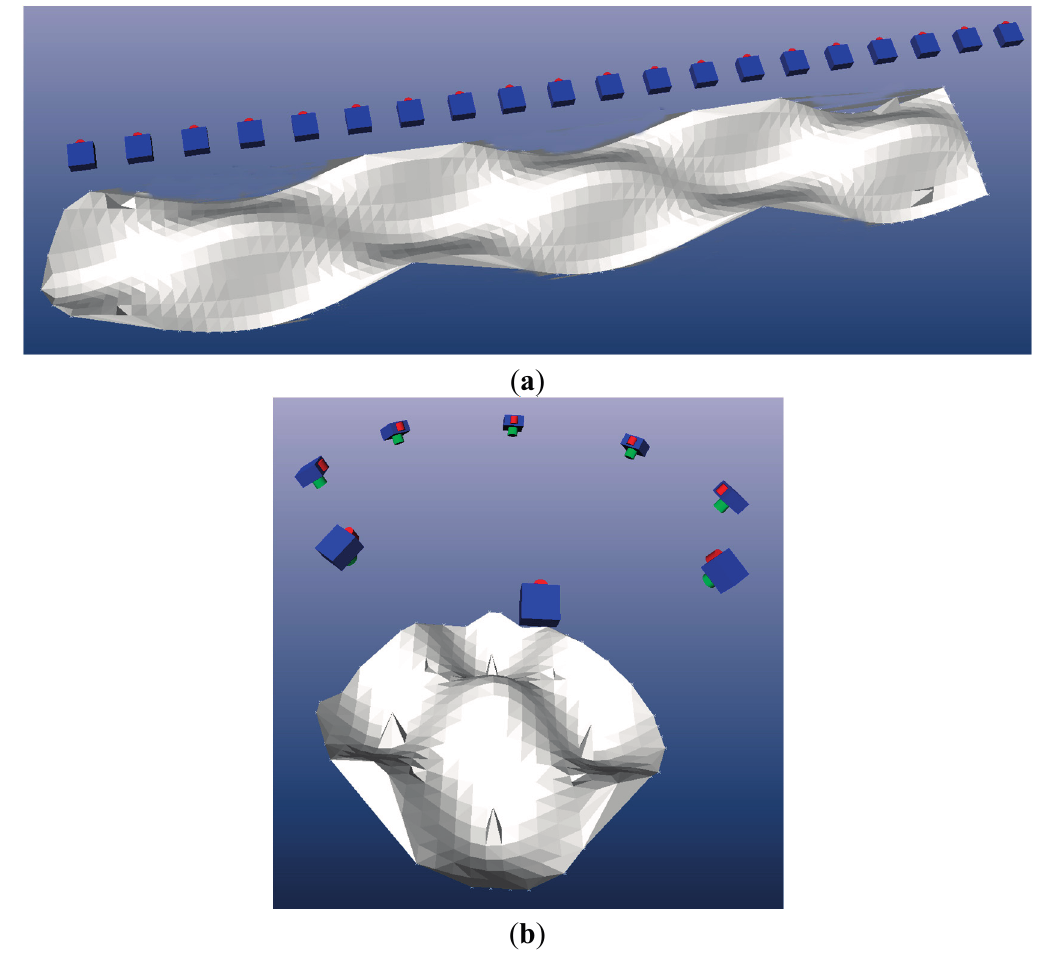
Figure 4. The two object shapes, including a typical camera network used as the basis for the numerical simulations: ( a ) single normal strip; ( b ) convergent circular